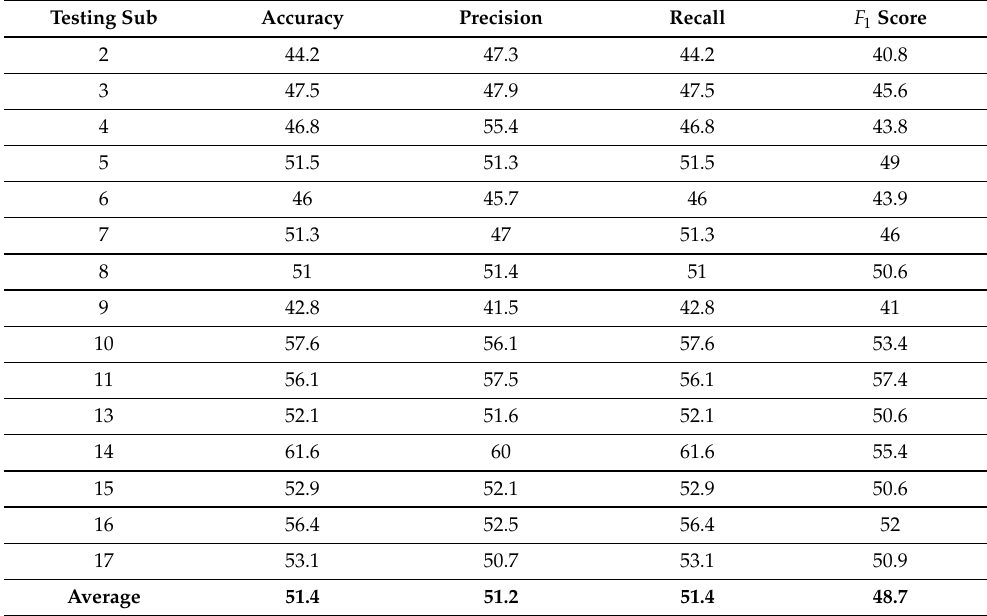
Table 2. Accuracy, precision, recall and F 1 score using 1D raw WESAD data with 1D CNN.